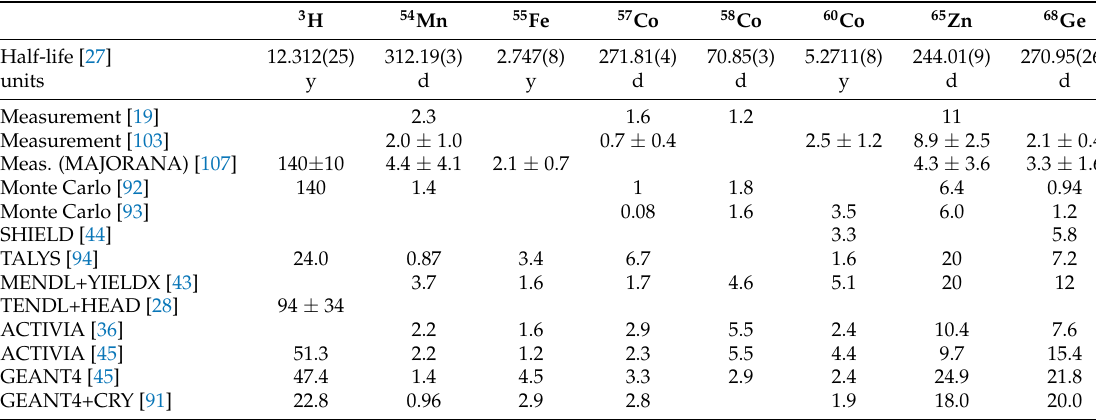
Table 1. Rates of production of long-lived radioisotopes induced in enriched germanium (as used in DBD experiments, typically 86% of 76 Ge and 14% of 74 Ge) at sea level. Measurements from Refs. [19,103,107] and different calculations are presented (see text). All numbers are expressed in